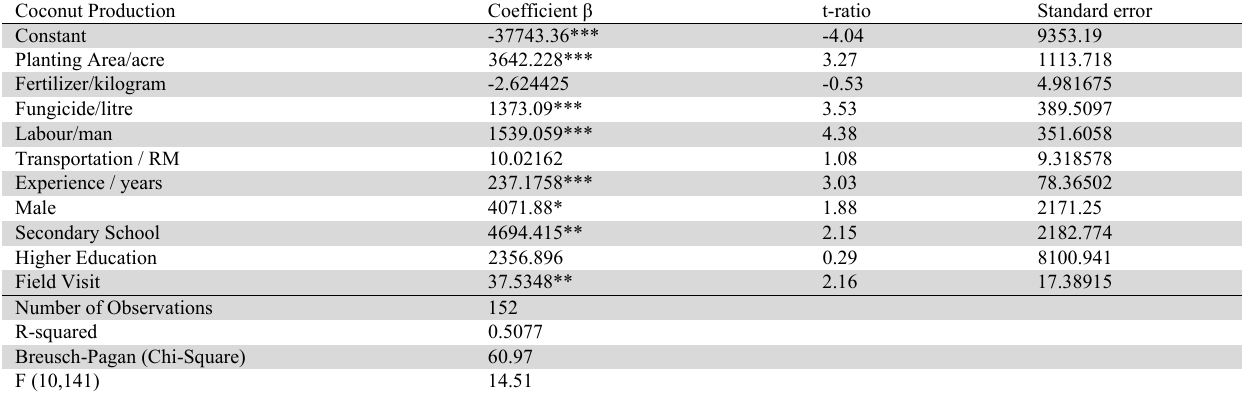
Multiple Regression